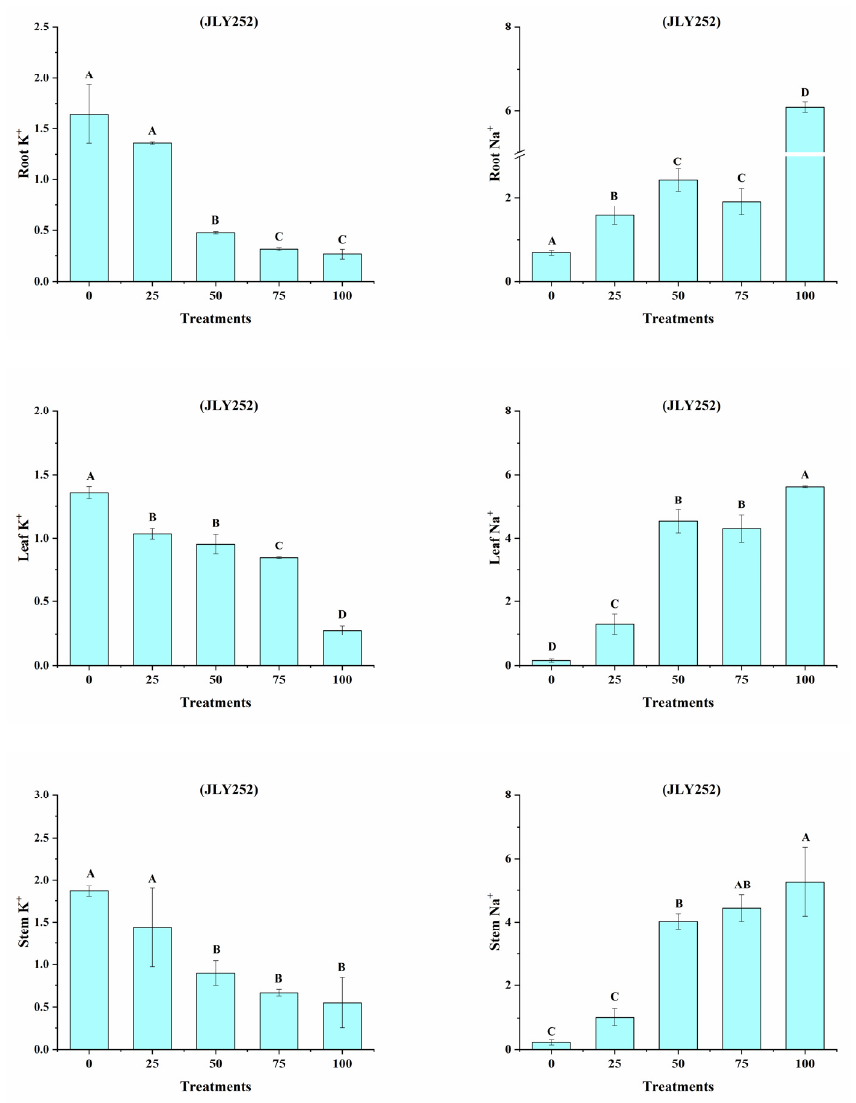
Figure 13. Na + , K + , and ratio in sensitive cultivar (JLY252) and five salt concentration treatments (0, 25, 50, 75, and 100 mM). Different letters showed the significant variance at p < 0.05.